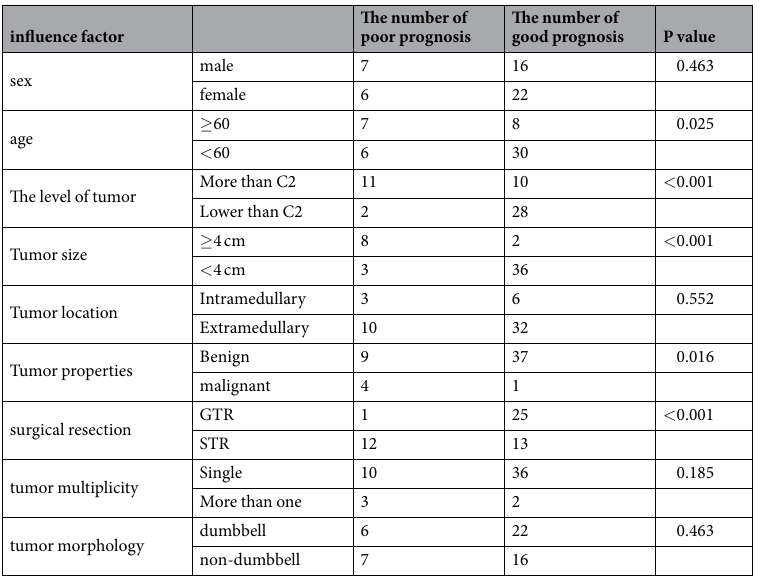
Table 4. Univariate analyses of variables possibly associated with prognosis.